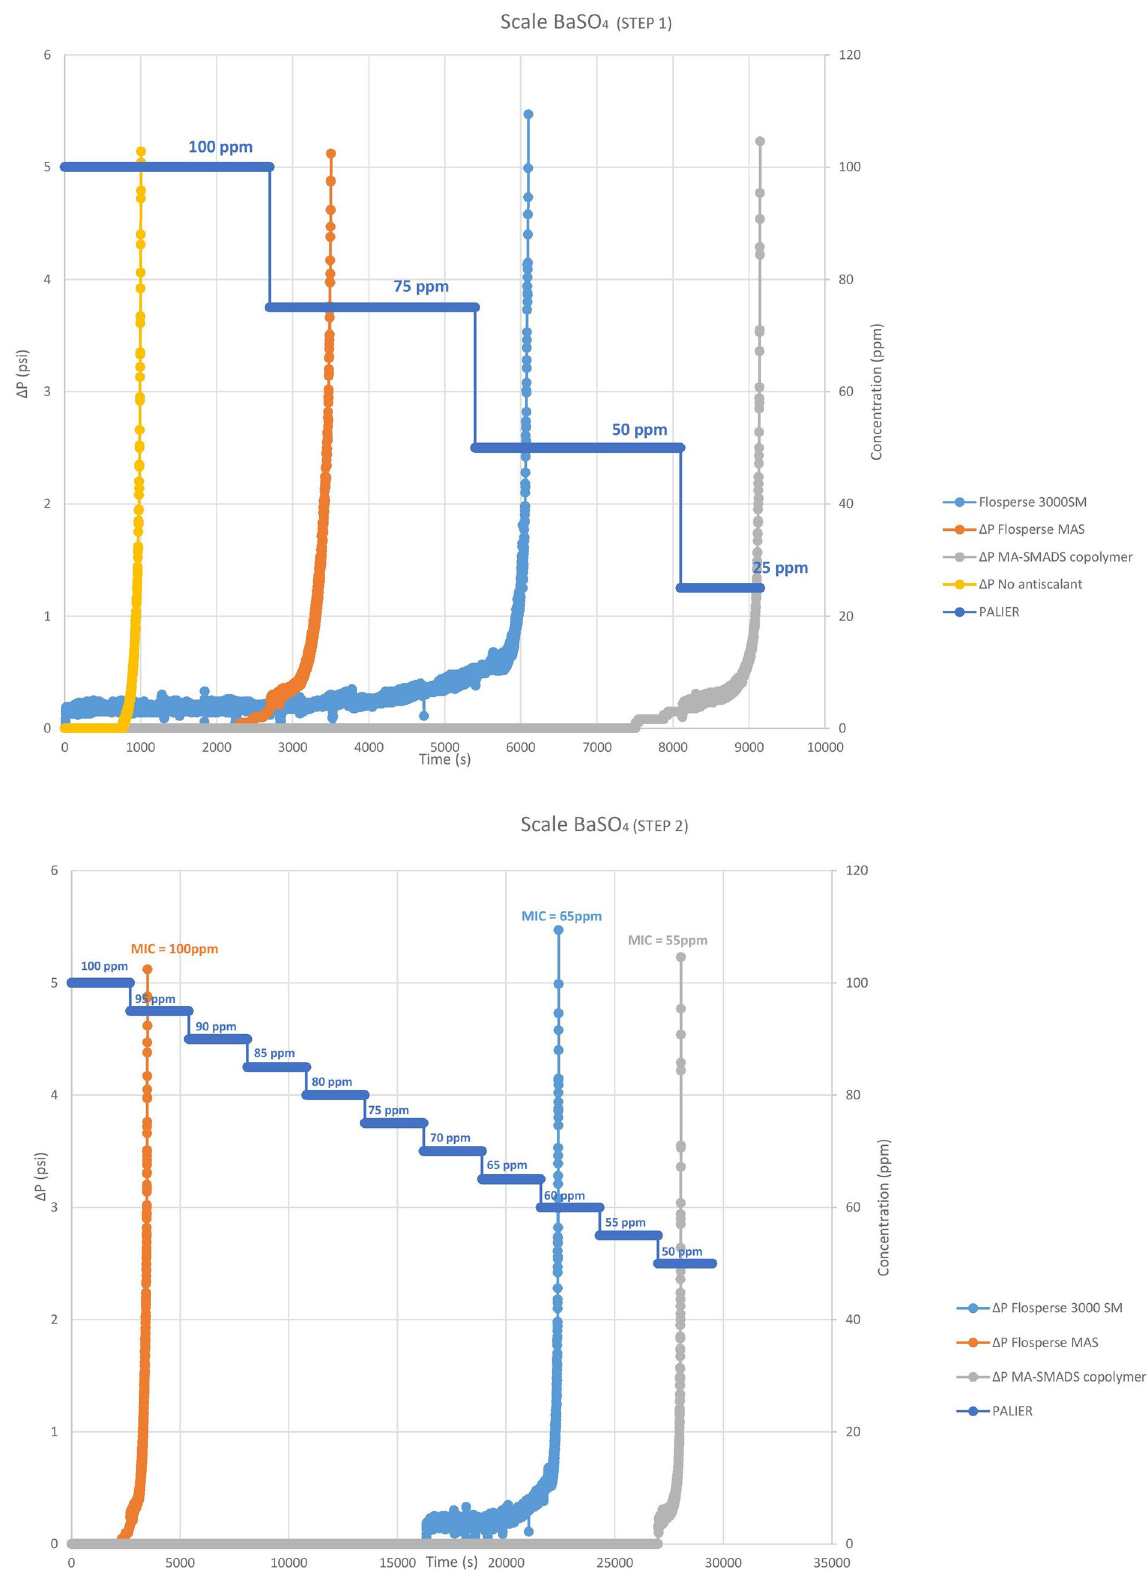
Fig. 12 Differential pressure versus time plot during scale inhibitor